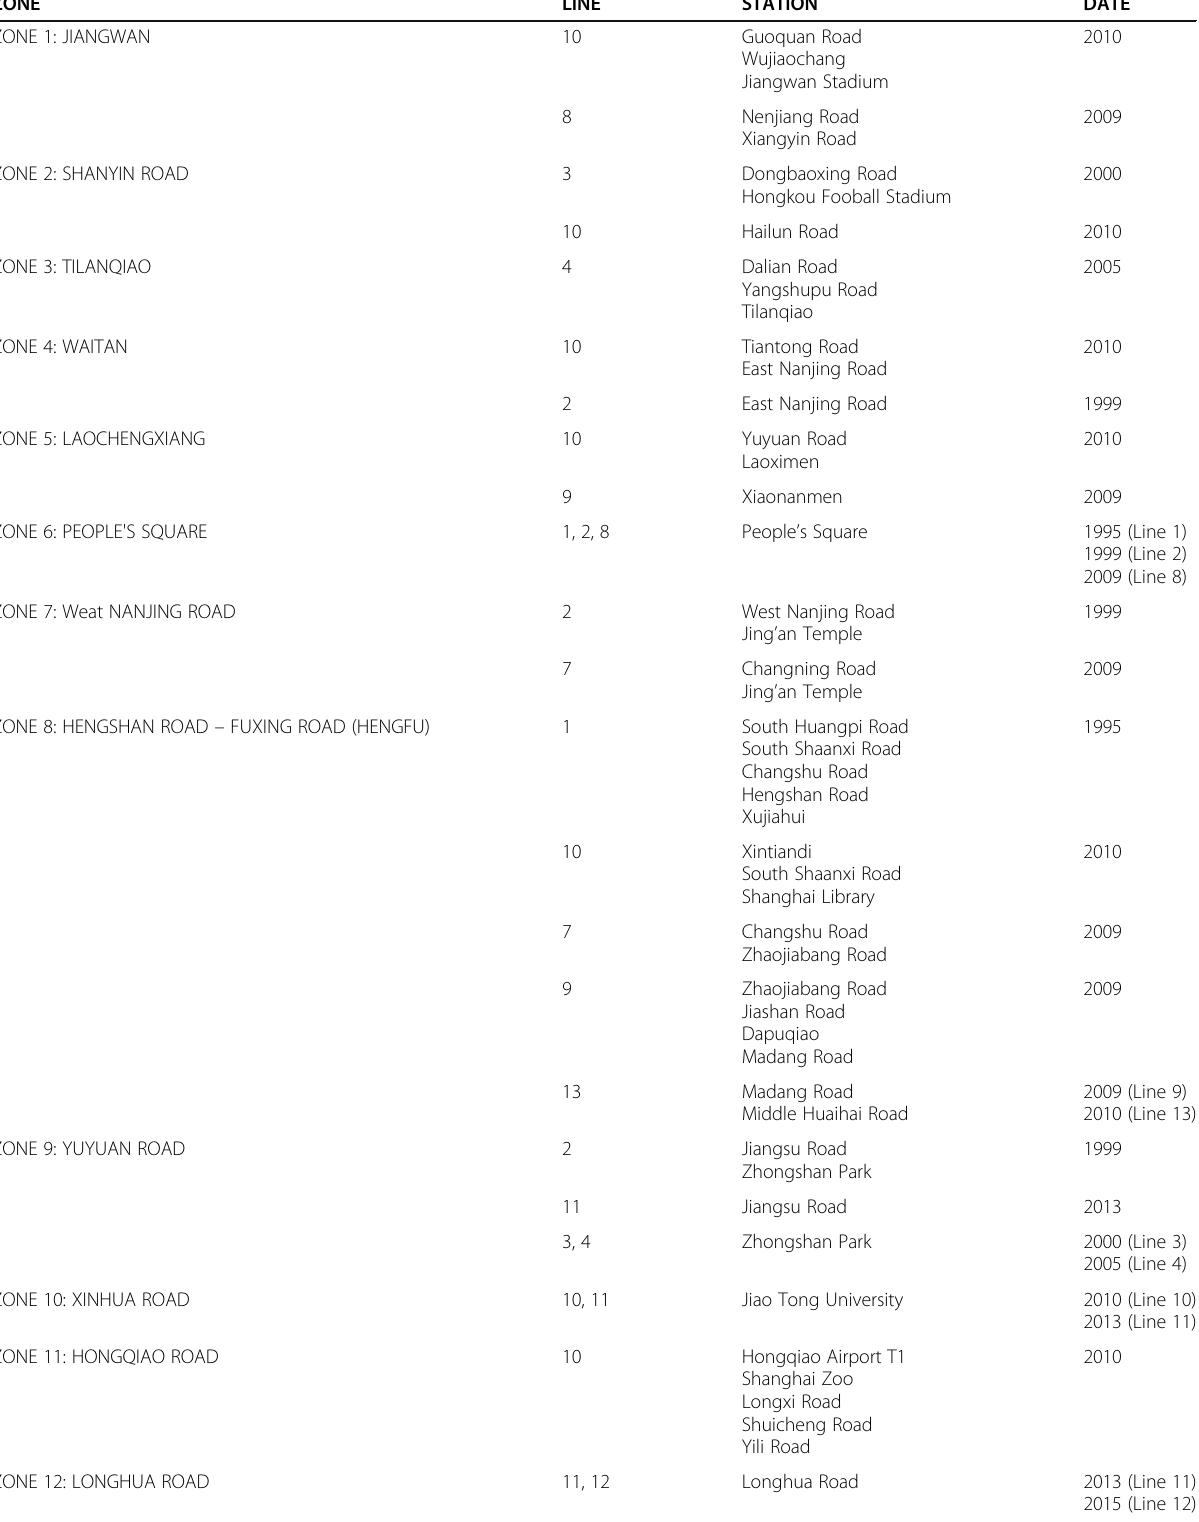
Table 1 The 12 heritage listed areas and the stations included in this study ZONE LINE